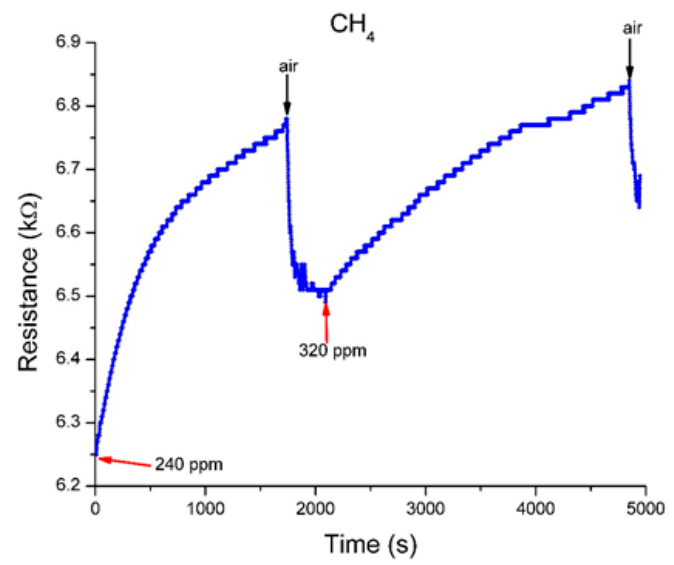
Figure 11. The sensor response to exposure at different concentration of CH 4 in N 2 .